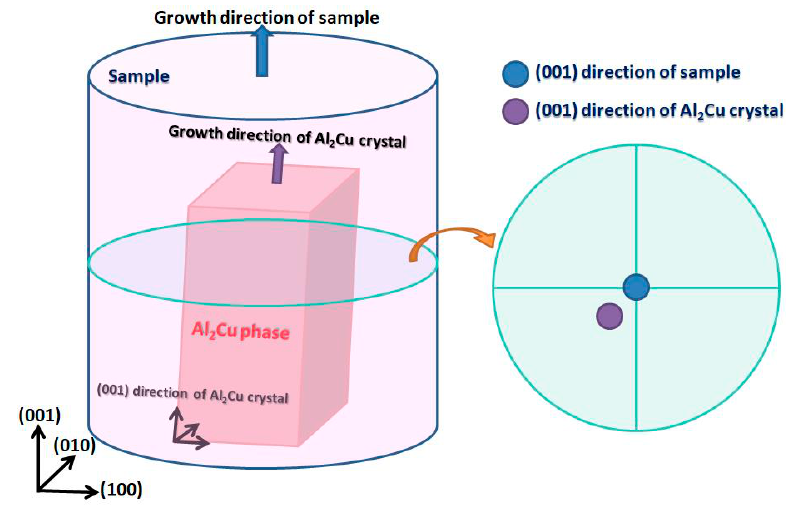
Figure 3. Schematic diagram of (100)-pole figure analysis of sample orientation.